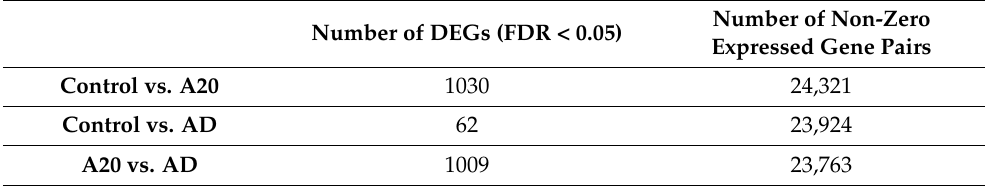
Table 1. Three-way comparisons outline based on CuffDiff [26] DEG detection.